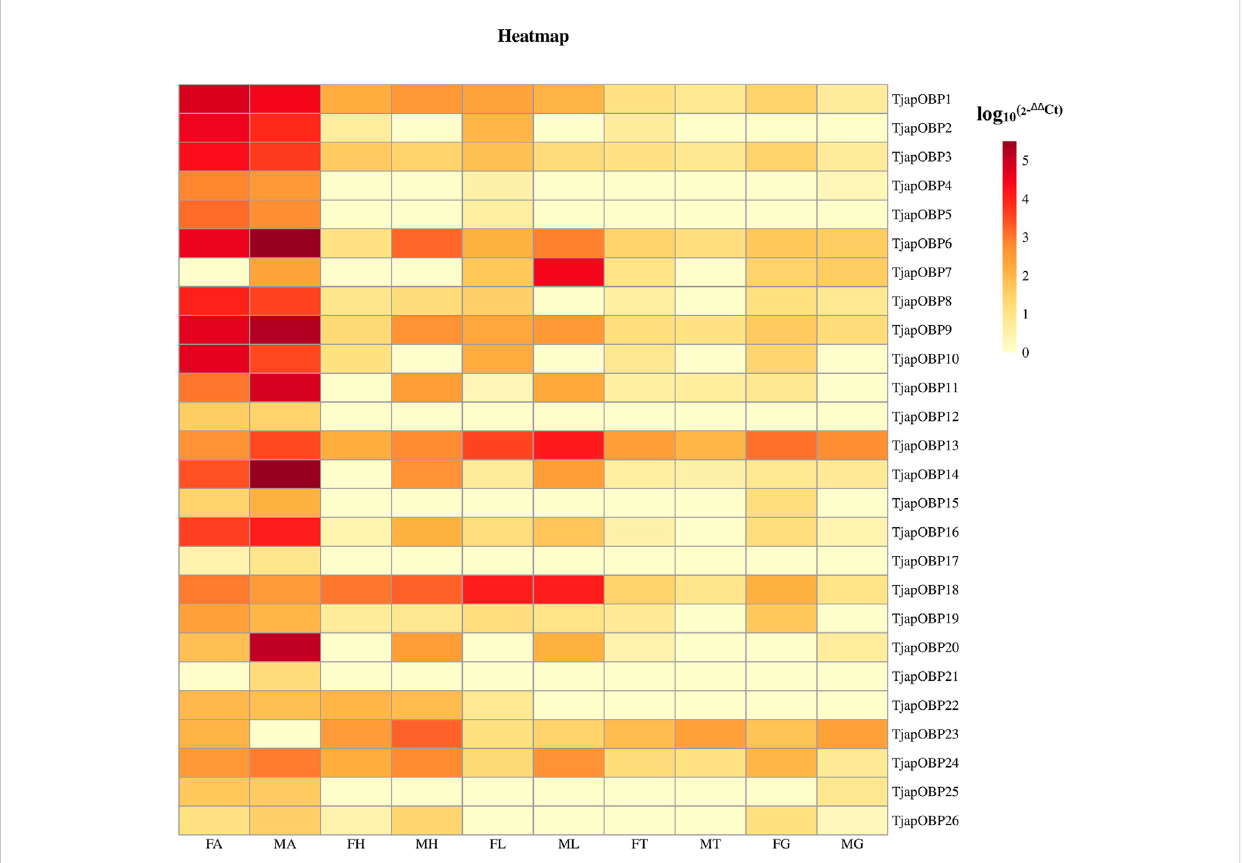
FIGURE 7 Relative expression levels of all TjapOBPs in different tissues of females and males. FA, female antennae, MA, male antennae, FH, female heads (without antennae), MH, male heads (without antennae), FT, female thoraxes, MT, male thoraxes, FG, female external genitals and MG, male external genitals. Note: the heatplot fi gure was built using the data set of